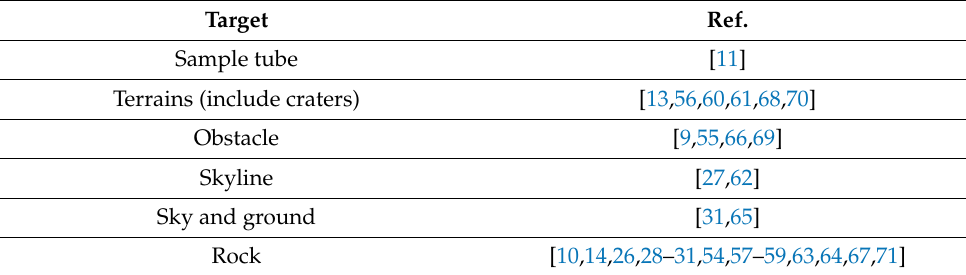
Figure 6. The ratio distribution by the target in the Included Study . Table 8. The reference list to corresponding targets in Figure